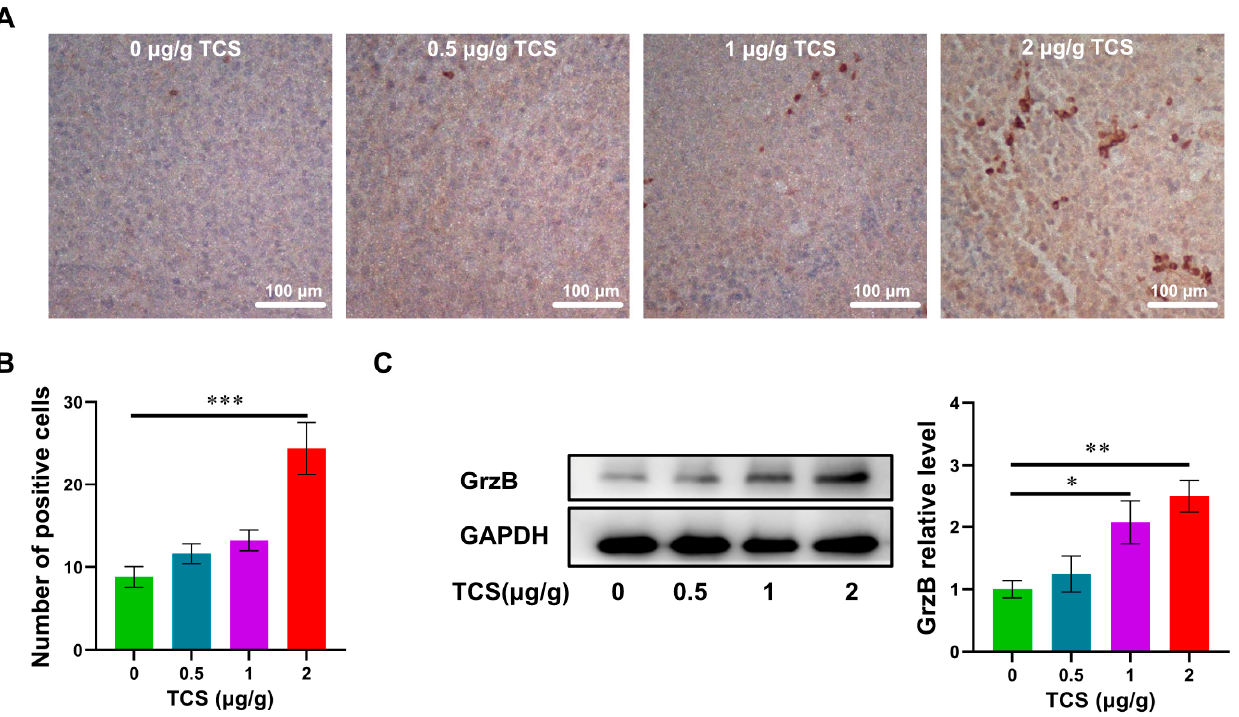
Figure 6. Effects of TCS on GrzB expression in vivo. ( A , B ) Immunochemical method detected GrzB in hepatocellular carcinoma tissues. Bar = 100 μ m; ( C ) Western blot method detected the level of GrzB in HCC tissues treated with different doses of TCS. *, p < 0.05; **, p < 0.01; ***, p < 0.001.